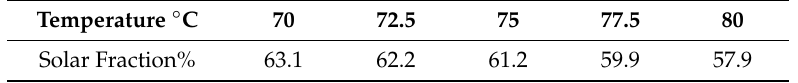
Table 7. Variation of the solar coverage with the lower temperature of the solar tank.